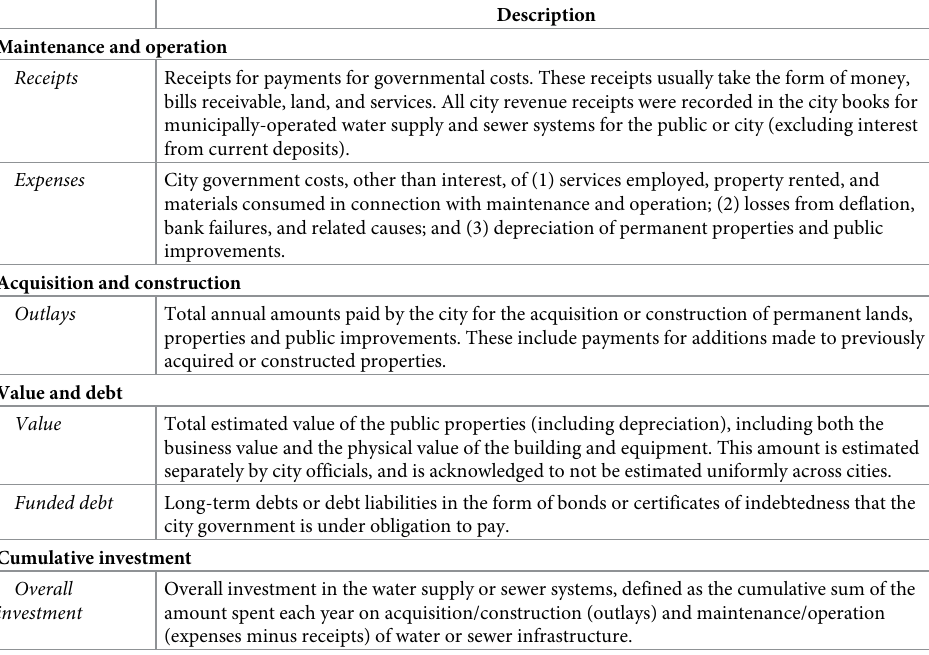
Table 1. Definitions of financial variables. Each of the six categories of financial variables used in this study are described, as defined by the U.S. Census Bureau in its annual “Financial Statistics” series (the source of these